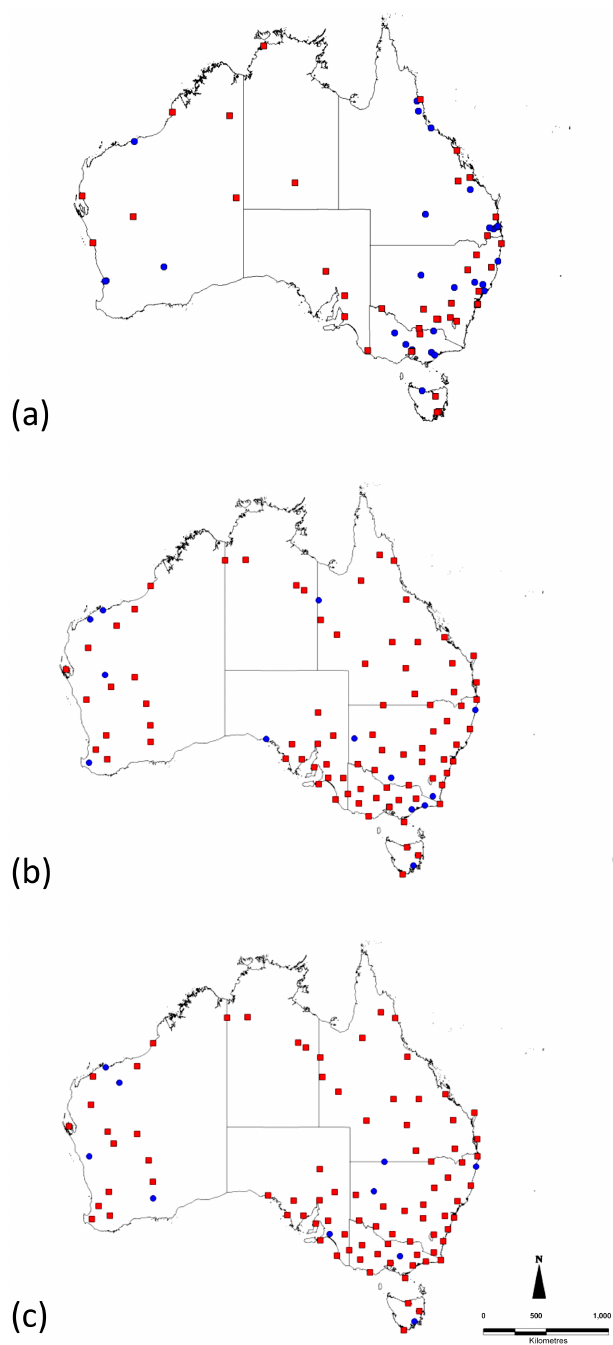
Figure 2. Stations (in red) with at least one statistically significant step change in the (a) 1h, (b) 1-day, and (c) 7-day annual maximum rainfall (using the Mann–Whitney U